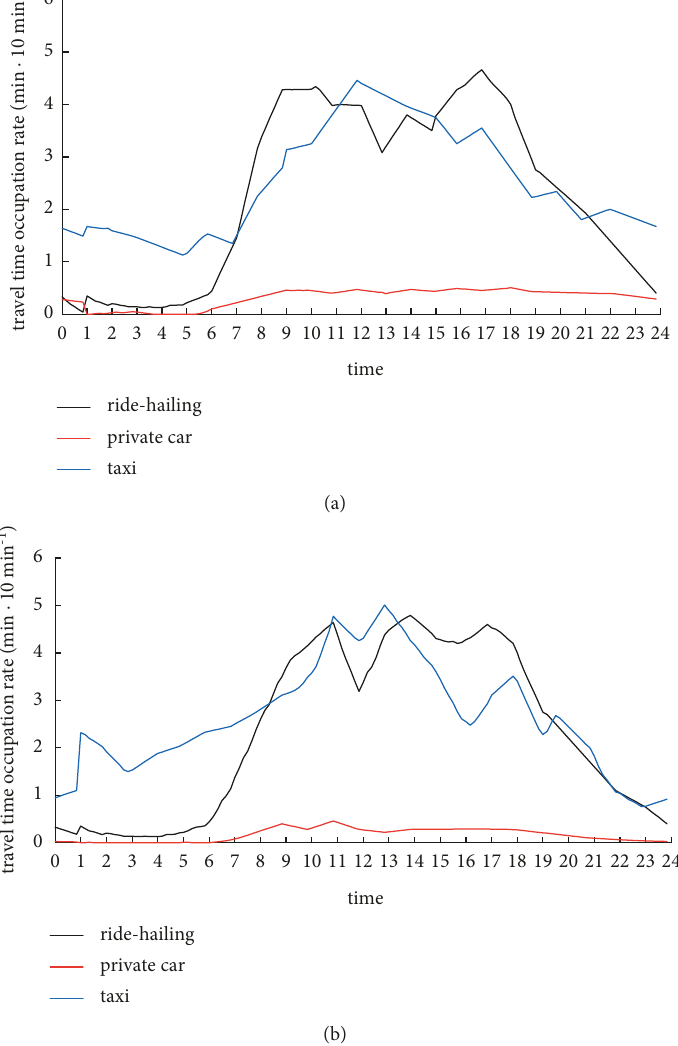
Figure 6: Average travel time occupation rate of ride-hailing vehicles, private cars, and taxis. (a) Working day. (b)